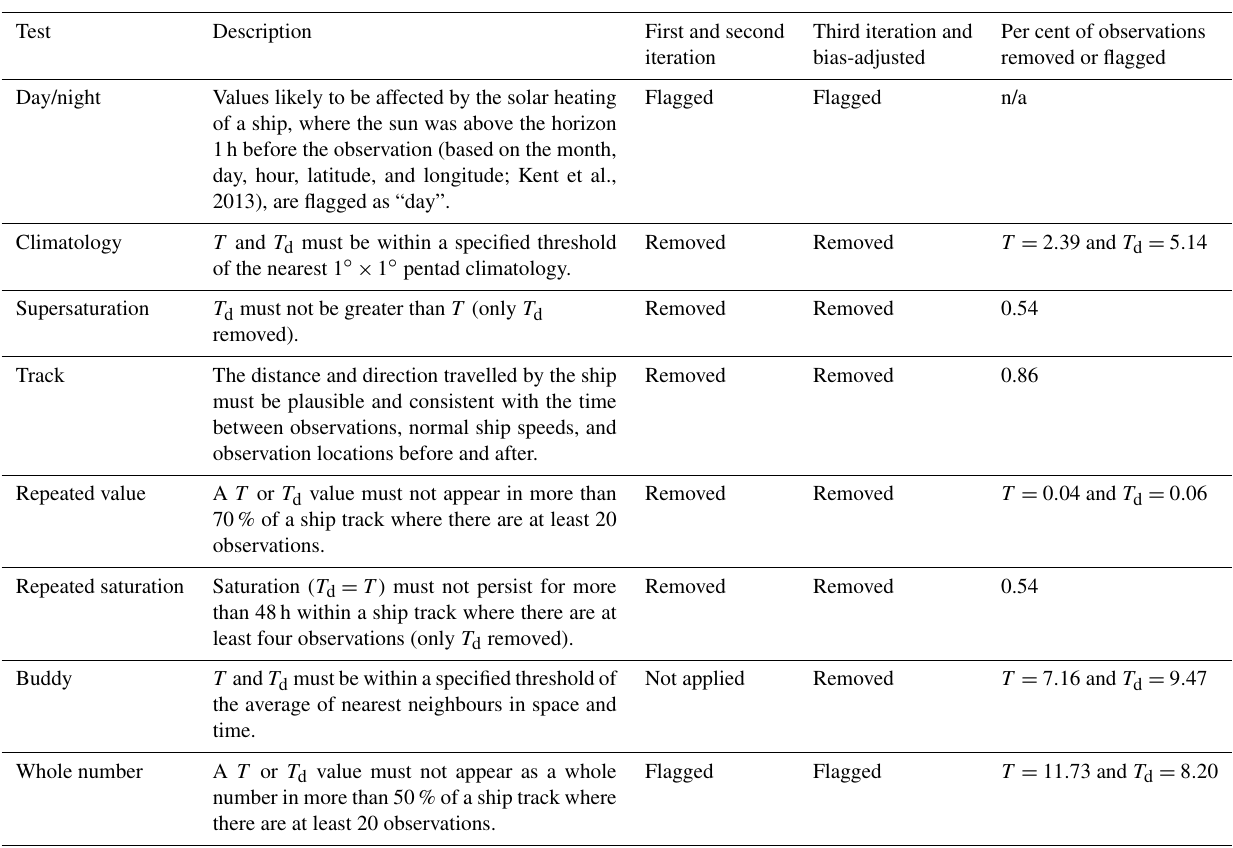
Table 1. Description of quality control tests. n/a – not